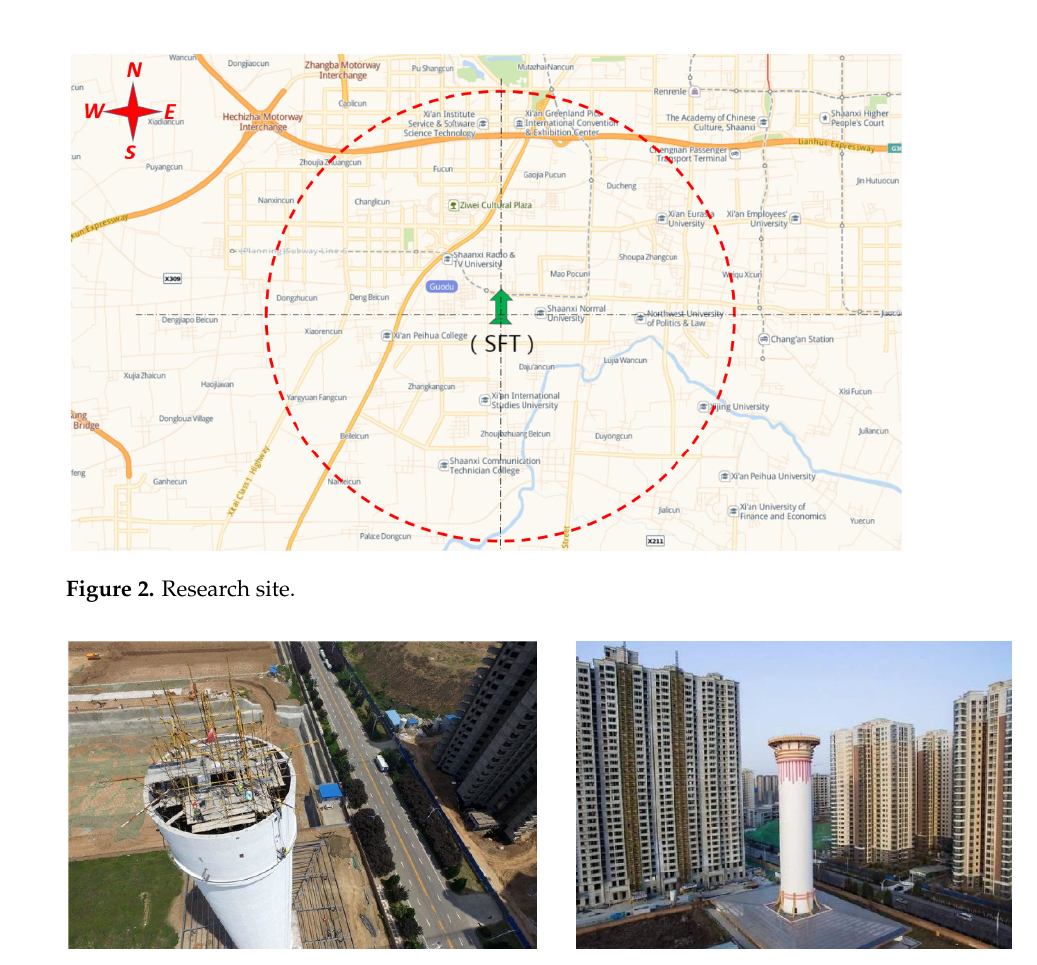
Figure 3. Pictures of the SFT (source: https://image.baidu.com, accessed on 12 July 2021). Table 1. Definition and descriptive statistics of the variables.